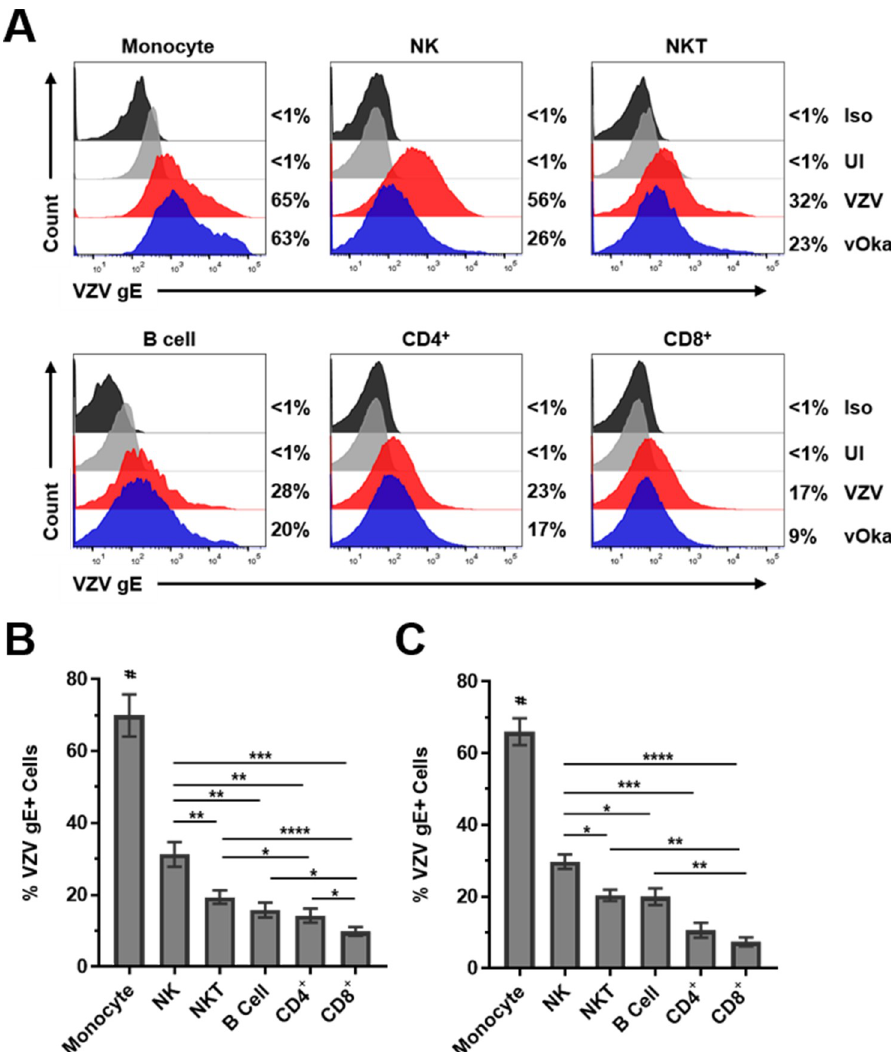
Fig 1. VZV infection of human monocytes, B cells, NK cells, NKT cells, CD4 + T cells and CD8 + T cells. (A) Human PBMCs were co-cultured with uninfected- (UI) or VZV-infected HFLs for 48 h then harvested and analyzed using flow cytometry. Specific cell types expressed the following markers: monocytes = CD3 - CD56 - CD19 - CD14hiMHC-II + ; B cells = CD3 - CD56 - CD19 + ; NK cells = CD3 - CD56 + ; NKT cells = CD3 + CD56 + ; CD4 + T cells = CD3 + CD4 + CD8 - , and; CD8 + T cells = CD3 + CD8 + CD4 - . Black histograms represent isotype control (Iso) stained VZV-infected cells, grey histograms represent UI cells, red histograms represent VZV-Ellen-infected cells (VZV) and blue histograms represent vOka-infected cells (vOka). Numbers on right side of each graph represent % VZV glycoprotein E-positive (gE+) cells. (B-C) Summary of flow cytometry analyses above from VZV-Ellen (B) and vOka (C) infections from 12 and 5 different healthy individuals, respectively, with bar graphs representing average % VZV-gE+ immune cells ± SEM. � P < 0.05, �� P < 0.01, ��� P < 0.001, ���� P < 0.0001; # above monocytes represents P < 0.01 (B) and P < 0.0005 (C) for significant increases in % VZV-gE+ monocytes compared to all other immune cell populations analyzed. Statistical significance was determined using RM one-way ANOVA with the Greenhouse-Geisser correction and Tukey